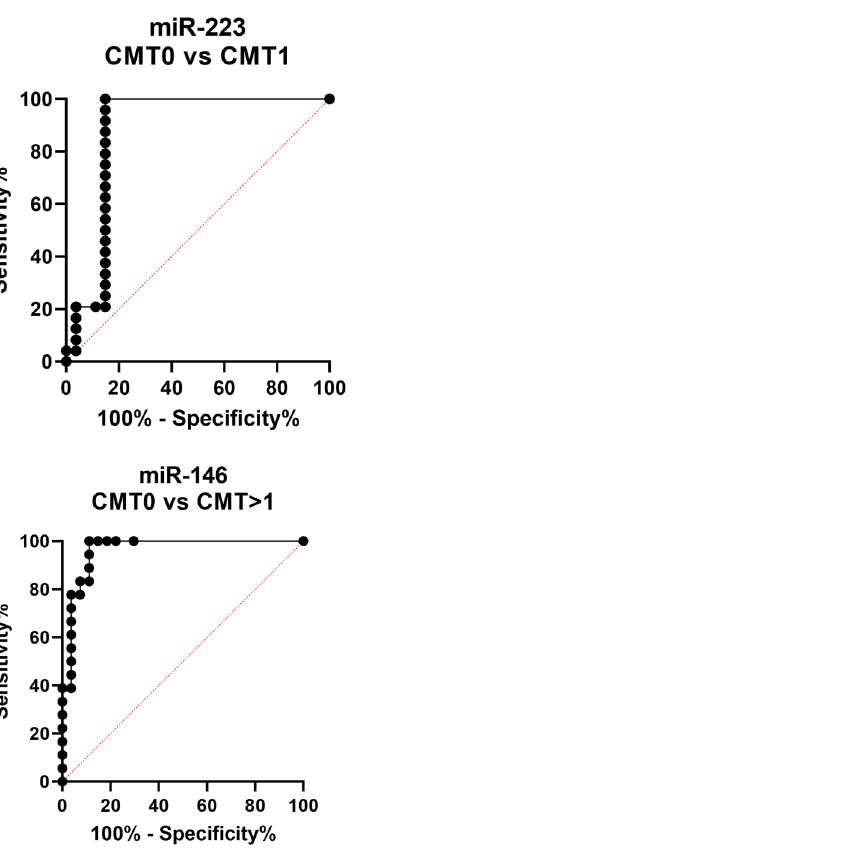
Figure 2. ROC curves obtained from the best performing miRNA predictor for each of the comparisons CMT 0 vs 1 (miR-223) and CMT 0 vs > 1